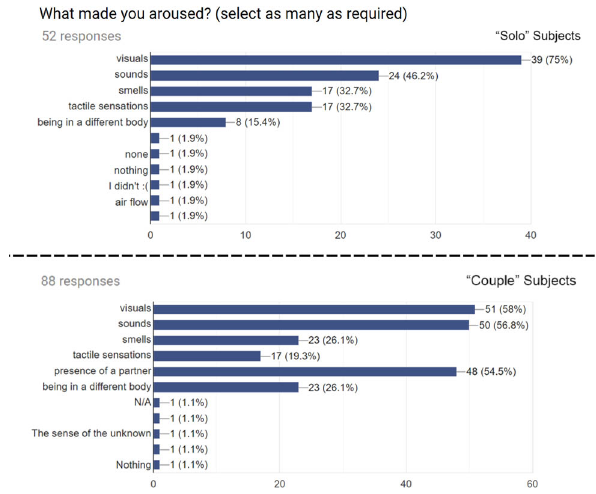
Figure 11: Charts indicating arousal level after the experience in “ Receiver ” ( above ) and “ Giver ” ( below ) subjects extracted from the self - report forms.